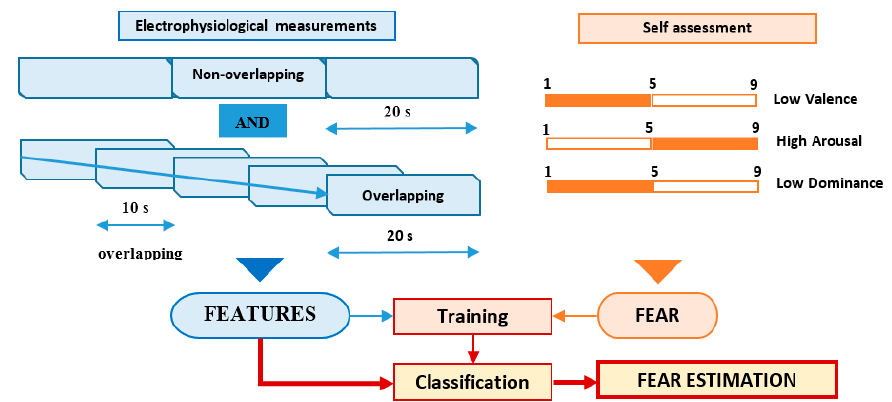
Figure 3. Fear classification process.